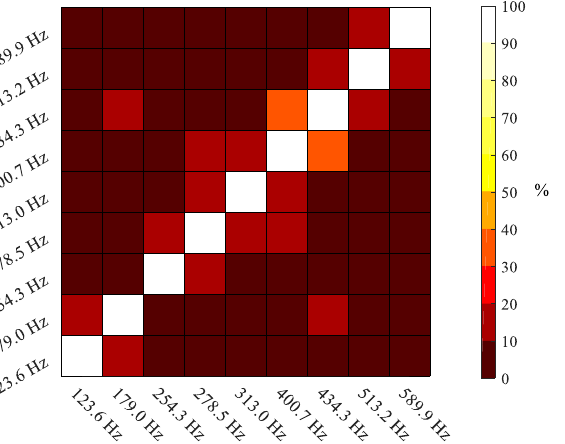
Figure 9. Auto modal assurance criterion (Auto-MAC) of the obtained modal model.